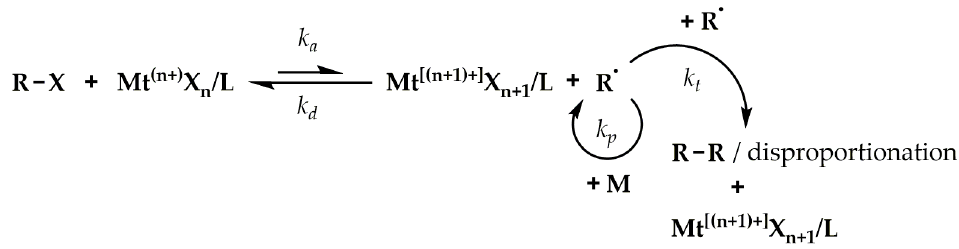
Figure 1. General scheme of an ATRP